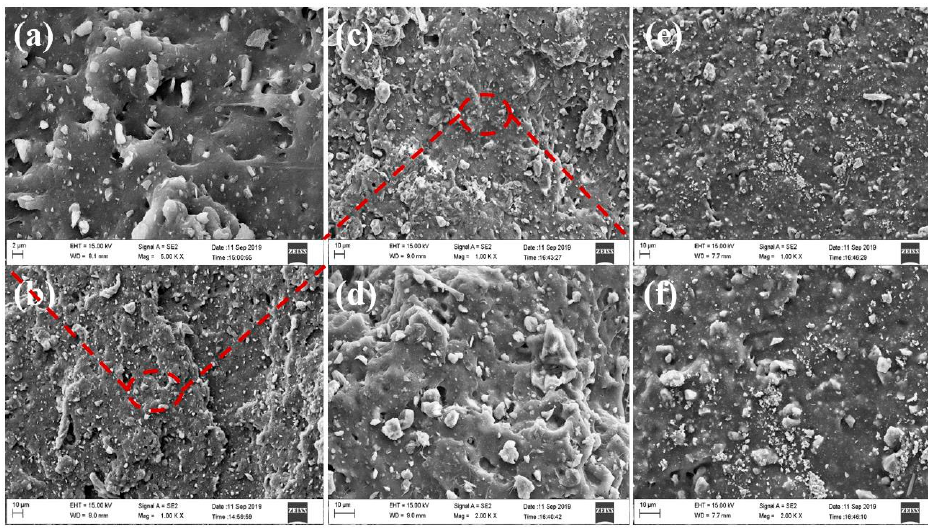
Figure 6. SEM pictures of unmodified zeolite/natural rubber under different loadings. Wherein ( a , b ) is an unmodified zeolite filled with 10 phr, ( c , d ) is filled with 30 phr, and ( e , f ) is filled with 70 phr.